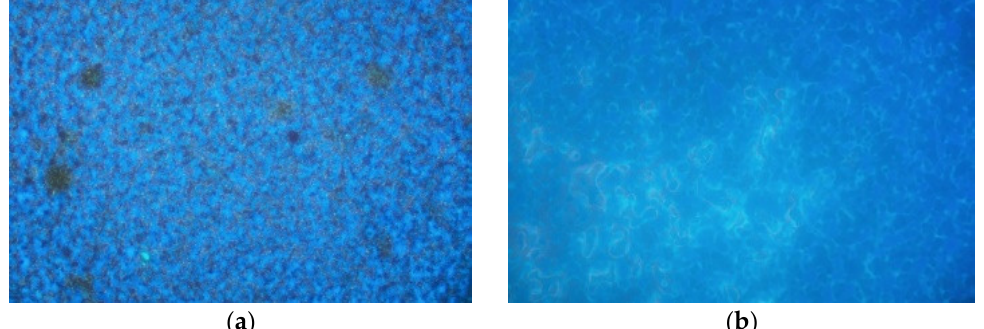
Figure 9. Fluorescent micro-structure of WE/A with 20% WER ( a ) 1 h; ( b ) 48 h.